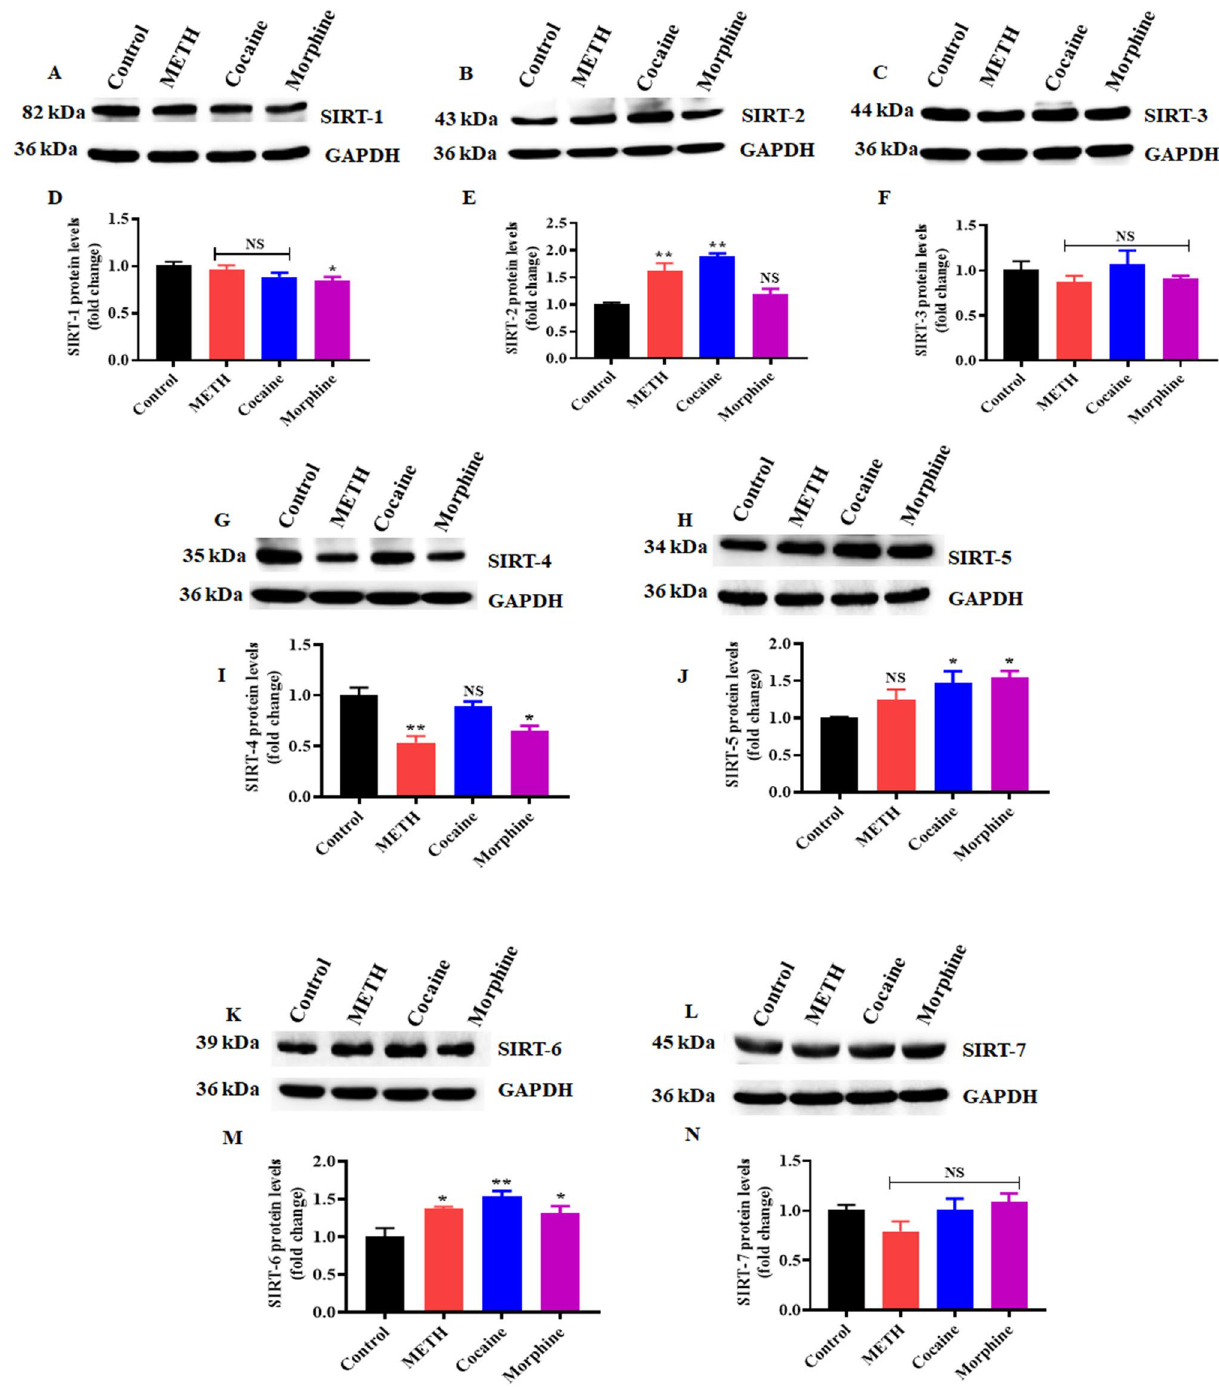
Figure 2. Effects of psychostimulants and opioids on SIRTs (1–7) in human primary microglia. Cells were exposed to METH (5 µM), cocaine (1 µM), and morphine (1 µM) for 24 h. The protein expression levels of different classes of SIRTs (1–7) in the microglia were determined using Western blotting analysis with GAPDH as a loading control. Western blot showing ( A ) SIRT-1, ( B ) SIRT- 2, ( C ) SIRT-3, ( G ) SIRT-4, ( H ) SIRT-5, ( K ) SIRT-6 and ( L ) SIRT-7. Densitometric analyses ( D – F , I , J , M , N ) represent the protein levels (fold-change from control). The data are expressed as the means ± SD of three independent experiments. ***P < 0.001, **P < 0.01, *P < 0.05, NS—Nonsignificant. Treatments groups were compared to Control. The supplementary information includes all full-length